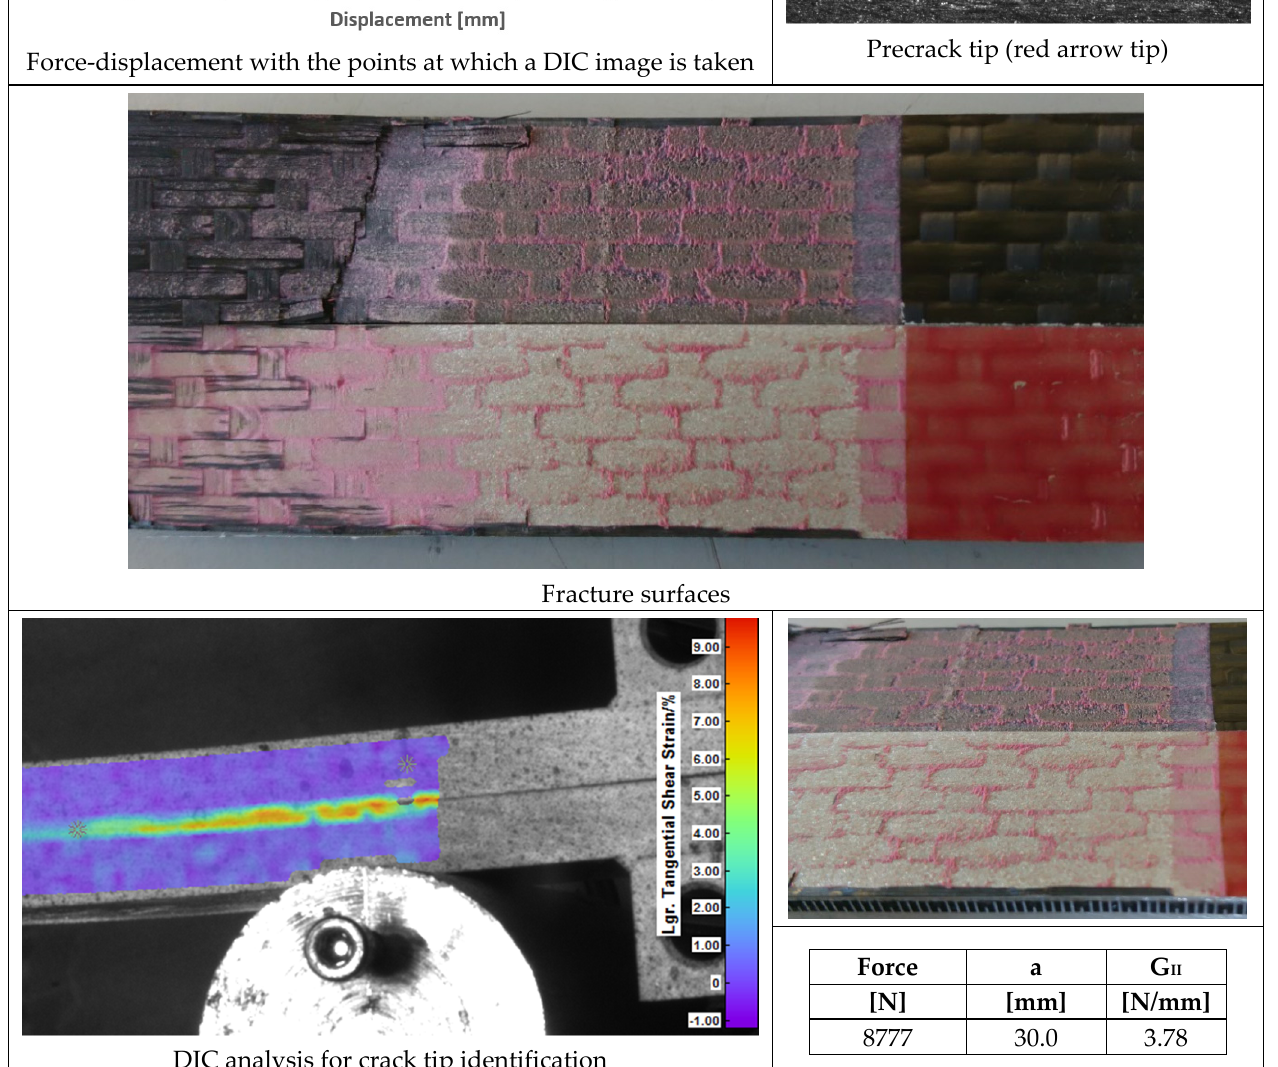
Figure 20. Results of the test on specimen ENF_AF163_01.